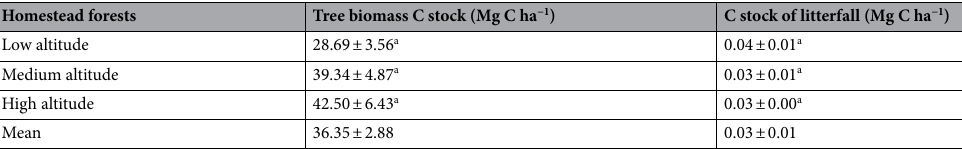
Table 1. Carbon stocks (Mg C ha −1 ) of tree biomass (above ground and living roots) and litterfall in the homestead forests sampled across three altitudes. ± represents the standard error of the mean. Same alphabet in different rows indicates the insignificant difference among the different altitude homestead forests (p ≤